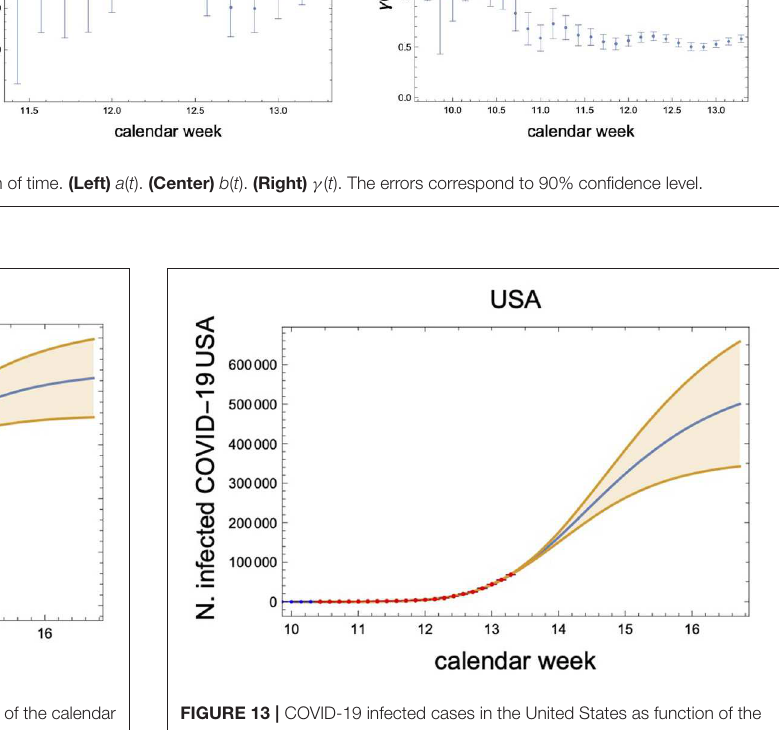
FIGURE 12 | COVID-19 infected cases in Denmark as function of the calendar week number. The curve and the band (90% confidence level) have been obtained by performing a fit w.r.t. a , b , and γ to the red data points. Nota bene that after the 13th of March we multiplied the number of reported new cases by five to take into account the policy change in the way potential cases were tested.